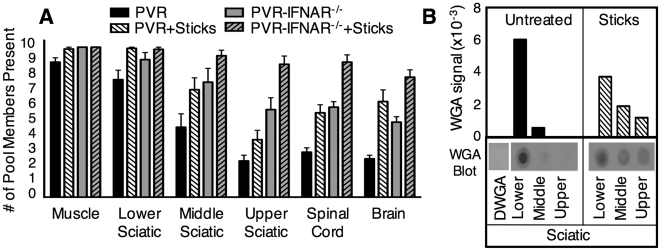
Quantification of retrograde axonal transport efficiency.(A) Efficiency of poliovirus transport and the effects of type I interferon and muscle damage. PVR and PVR-IFNAR−/− mice were intramuscularly inoculated with 2×107 PFU of the ten marked viruses, and were treated with or without needle sticks twice per day to induce muscle damage. Tissues were harvested at disease onset, and viral diversity was quantified. PVR mice, solid black bars; PVR mice with needle sticks, white hatched bars; PVR-IFNAR−/− mice, grey bars; PVR-IFNAR−/− mice with needle sticks, grey hatched bars. Results are expressed as mean with SEM, representing 4-13 mice per group. Statistically significant differences between groups are described in the text. (B) Efficiency of wheat germ agglutinin (WGA) transport and the effects of muscle damage. PVR mice were intramuscularly injected with 5 µg of WGA and treated with or without needle sticks. Tissues were harvested at 6 hours post-injection, and were processed for “dot-blot” protein immunoblot analysis. A WGA immunoblot, representative of four experiments, is shown under densitometry quantification (arbitrary units). Signal was normalized to sciatic nerve tissue from PVR mice not injected with WGA (denoted ΔWGA). Total WGA signal in the sciatic nerve represented approximately 1% of the WGA signal in muscle (data not shown).